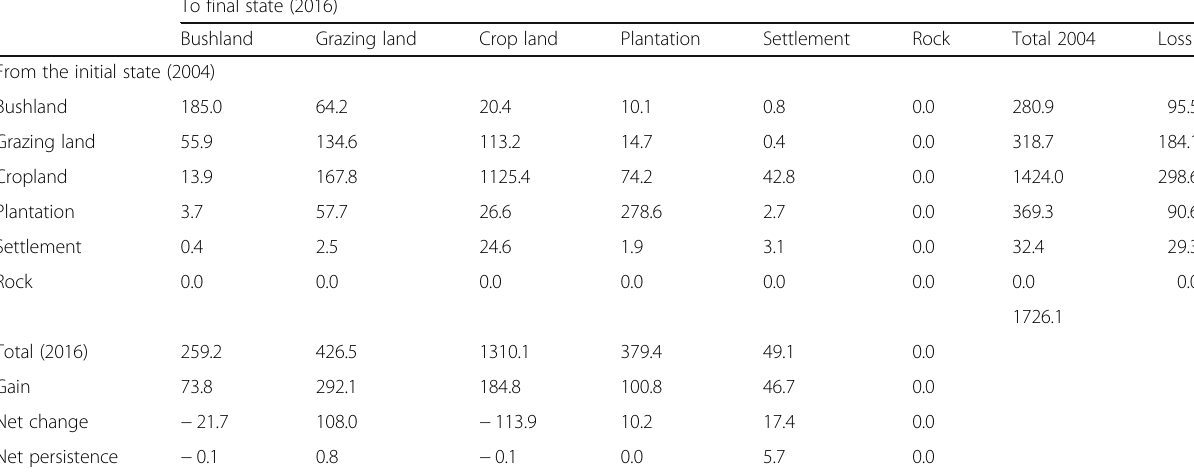
Table 6 LULC transition matrix showing major changes in the landscape 2004 – 2016 (%) To final state (2016) Bushland Grazing land Crop land